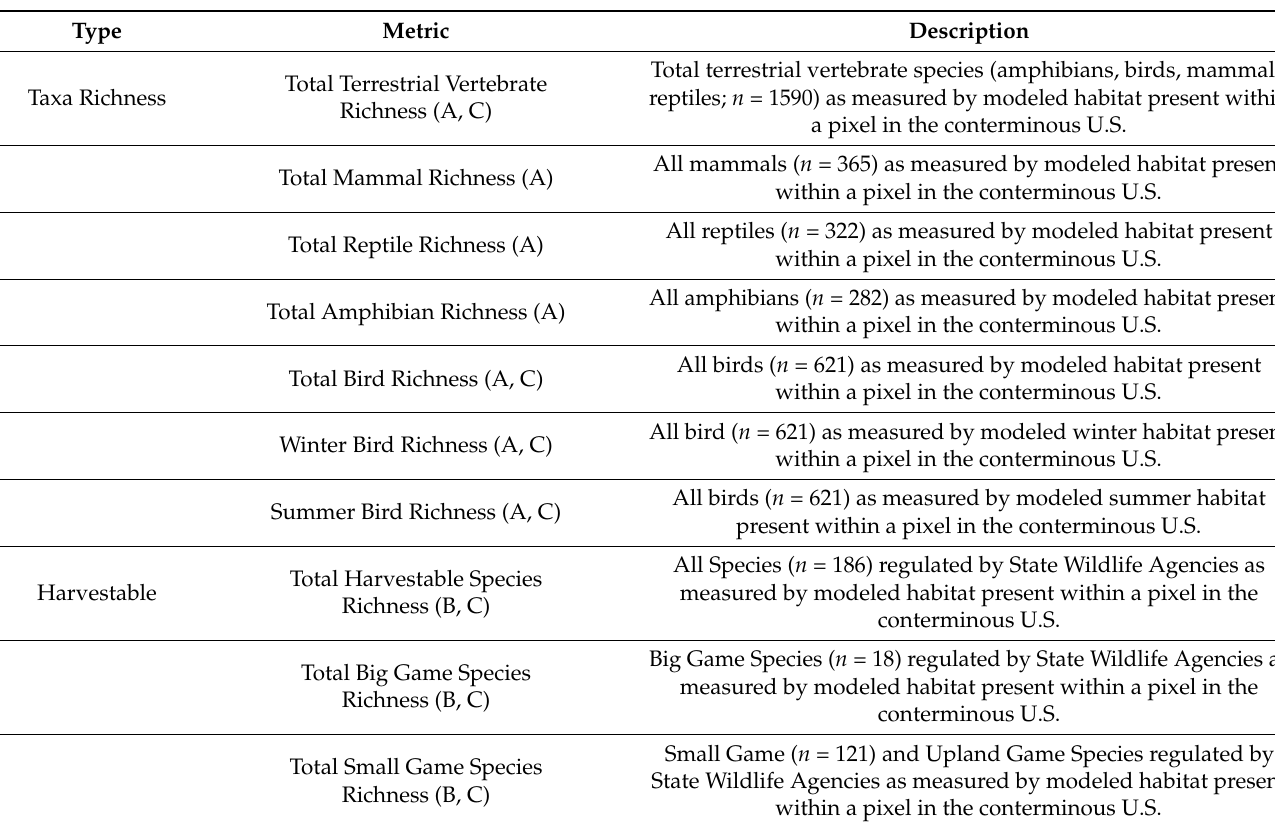
Table 1. National biodiversity metrics that reflect (A) biodiversity conservation; (B) food, fiber, and materials; and (C) recreation, culture, and aesthetics [31]. Also see additional descriptive information about each metric in the associated EnviroAtlas Fact Sheet (https://www.epa.gov/enviroatlas/enviroatlas-fact-sheets accessed on 25 March 2021).